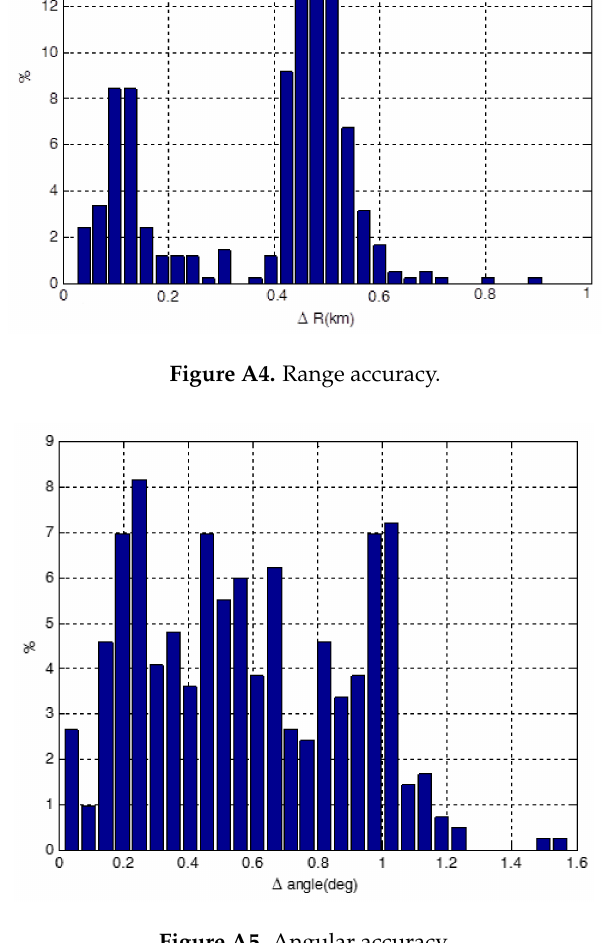
Figure A5. Angular accuracy.